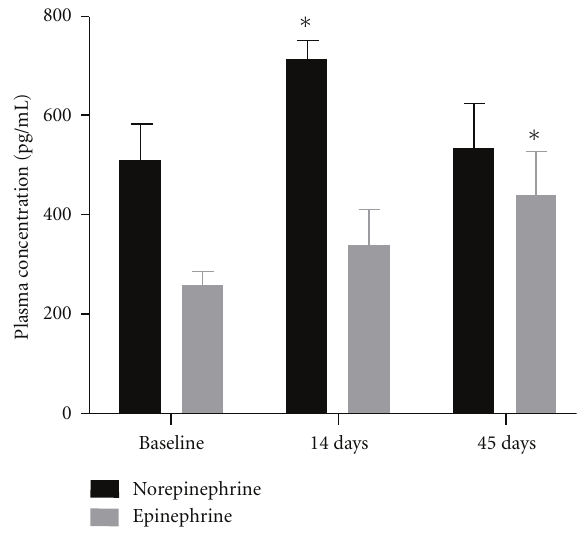
Figure 7: Plasma norepinephrine and epinephrine levels measured at the indicated time points during doxorubicin administration in calves. ∗ P < 0 . 05 versus baseline; n =